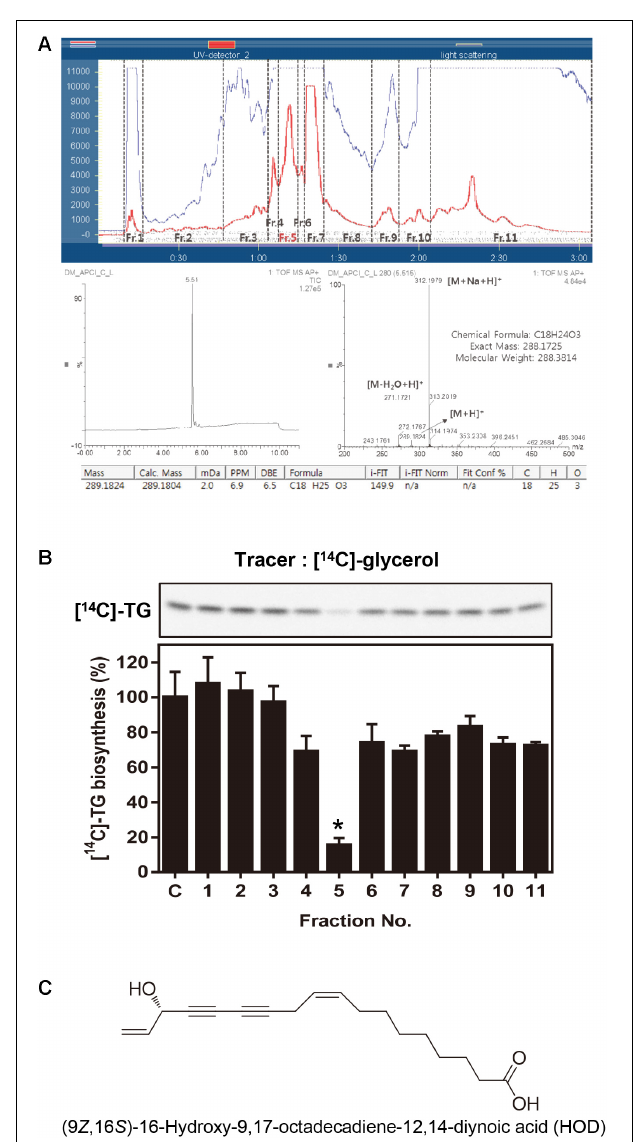
FIGURE 1 | Activity-guided fractionation and identification of HOD. (A) Sepbox separation and UPLC-CAD chromatogram data. (B) 30 µ g/ml of eleven fractions were treated in HepG2 cells and evaluated newly biosynthesized TG. Lipid profile analyzed by TLC using [ 14 C]-glycerol as radiolabeled substrates. (C) Chemical structure of HOD. Significance: ∗ p < 0.05 vs.